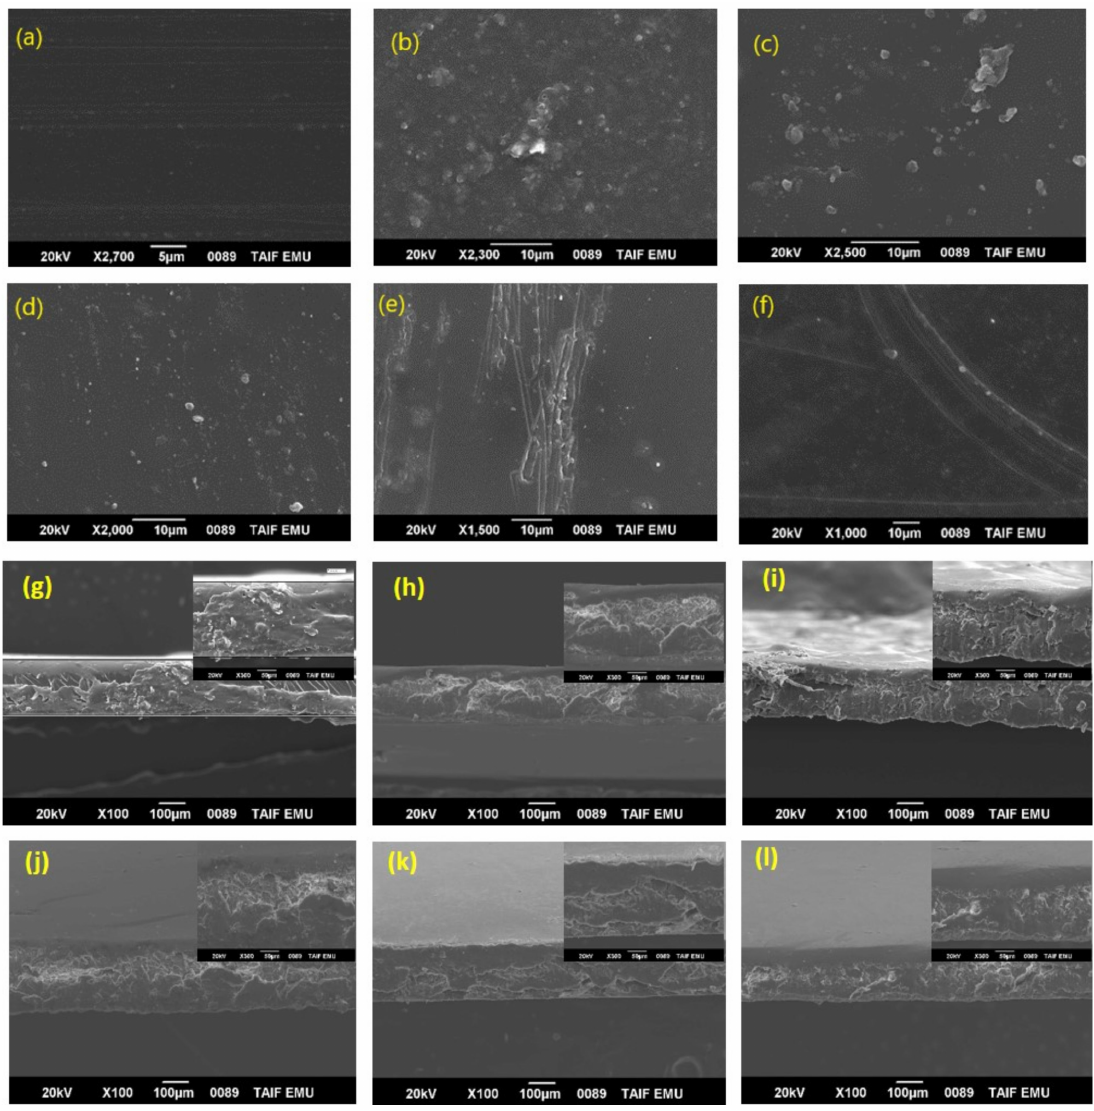
Figure 3. SEM images (top-surface and cross-section) of pure PSF ( a , g ), PSF/MMt ( b , h ), PSF/MMt/G ( c , i ), PSF/MMt/GO ( d , j ), PSF/MMt/CNTs ( e , k ), and PSF/MMt/CNTOxi ( f , l